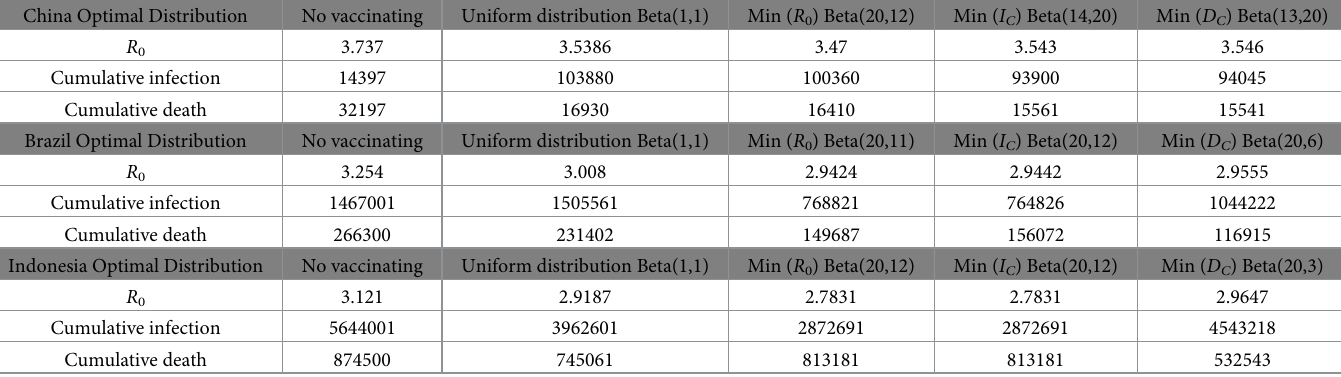
Table 5. The final outcomes with the optimal age-specific distributions vs. the uniform distribution and no vaccinating for the three countries: China, Brazil and